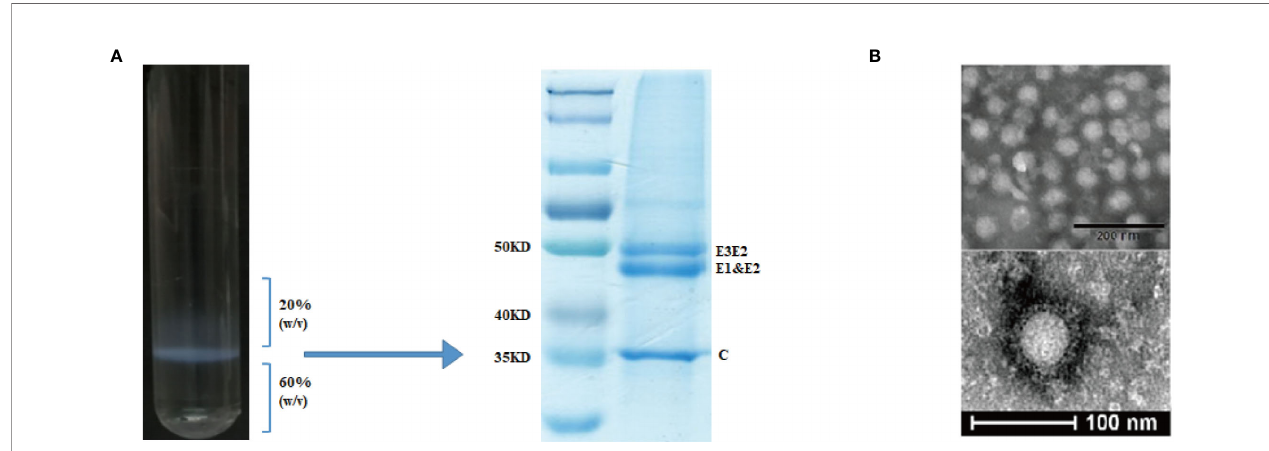
FIGURE 2 | Puri fi cation and characterization of CHIK-VLPs. CHIK-VLPs separated at the 20-60% sucrose density gradient interface, SDS-PAGE followed by Coomassie blue staining (A) . Electron microscopy of negatively stained CHIK-VLPs puri fi ed by sucrose gradient (B) .